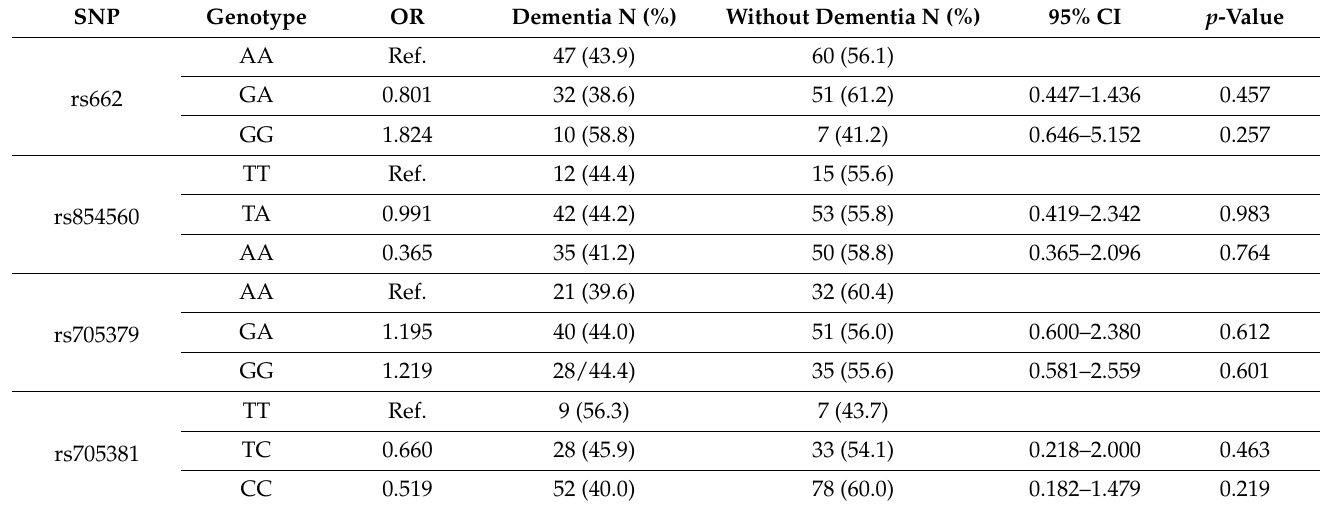
Table 6. Associations between dementia status and PON1 single-nucleotide polymorphisms (SNPs).